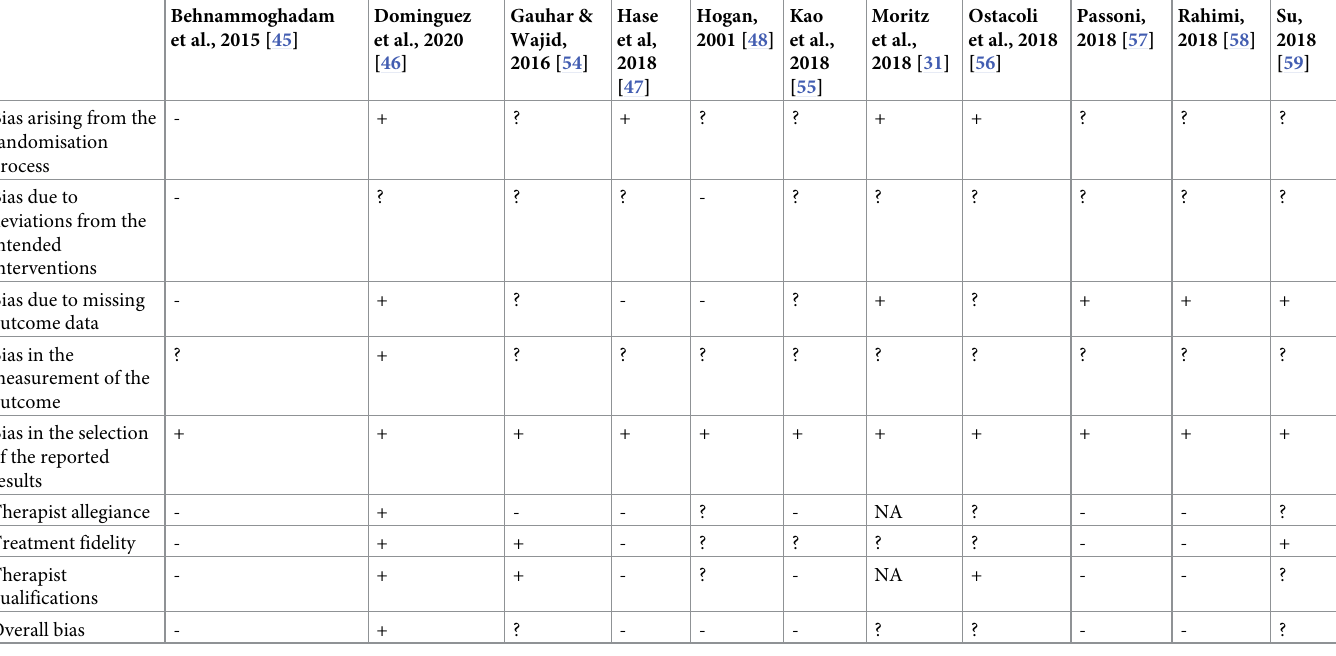
Results of the quality analysis are presented in Tables 1 and 2. Of the 11 studies, one was rated as low risk of bias, six were rated as being high, and four were rated at some risk. All studies reported at least some risk of bias with regard to deviations from the intended interventions as neither the therapist nor client could be blind to the treatment condition. Further, all but one study was rated as some risk bias regarding the measurement of the outcome as they relied only on self-report data. Dropout numbers ranged from 0% to 35%, with two studies not reporting the attrition rates.